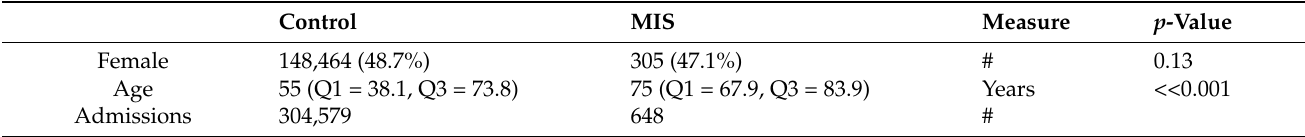
Table 1. Gender and age distribution before PSM.